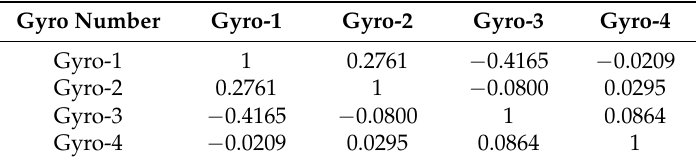
Table 2. Cross-correlation matrix of RRW noise for four-gyro array (Test 1).